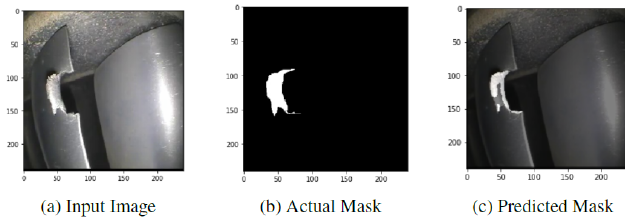
Figure A6. JL segmentation on test data after 150